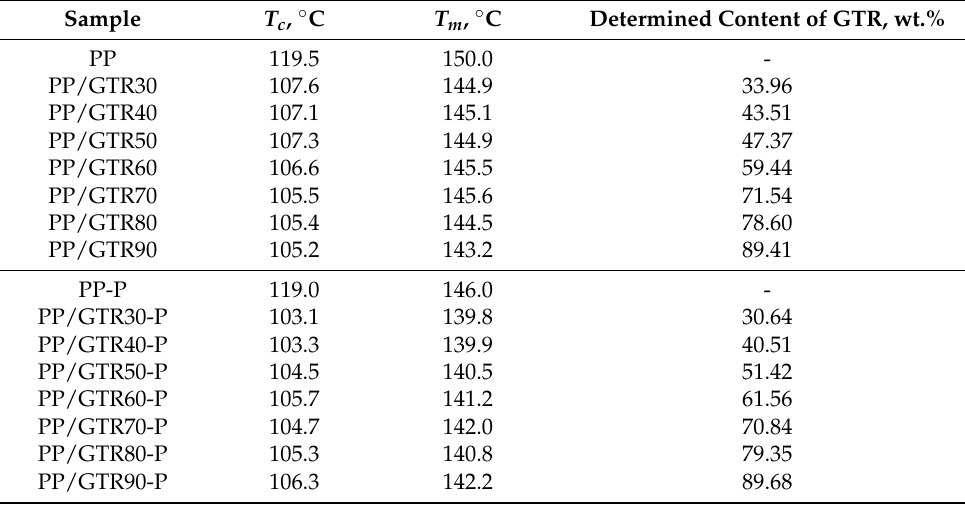
Table 4. Results of calorimetric measurements .